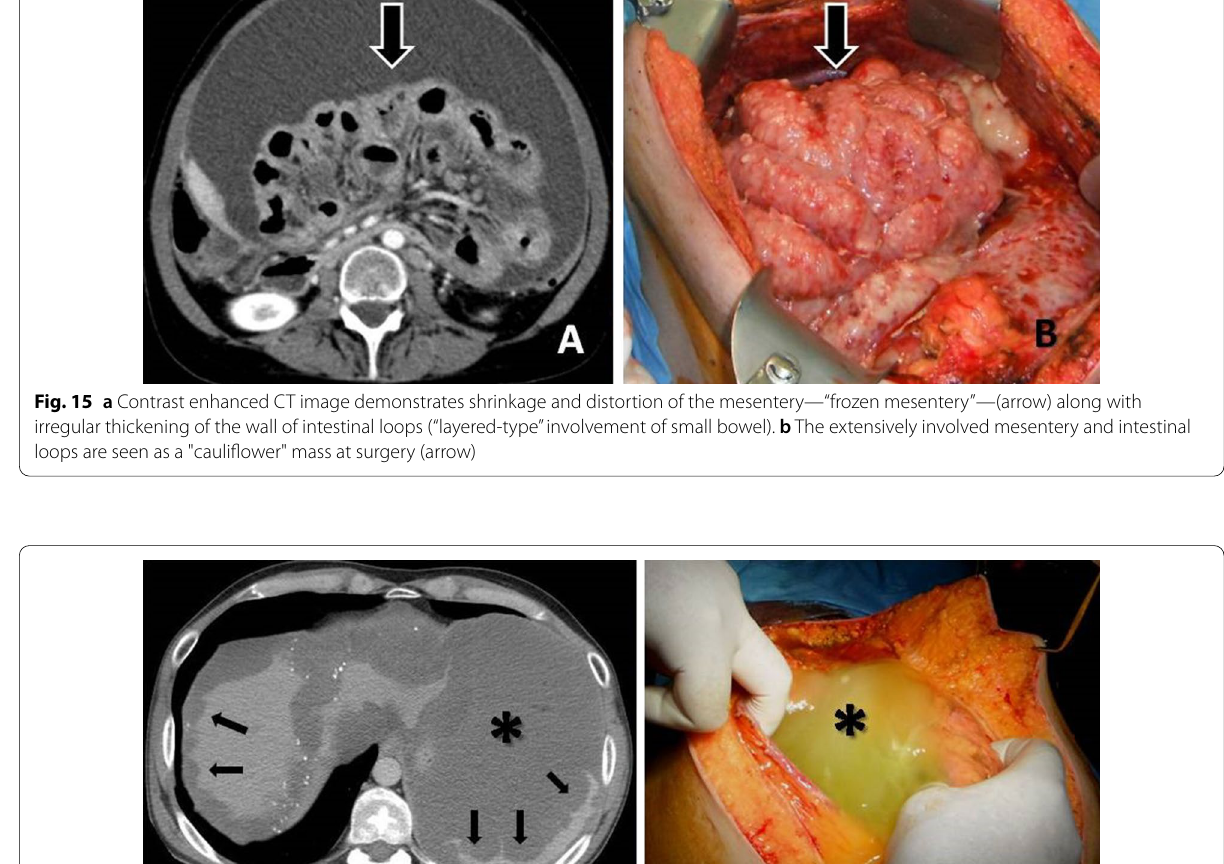
Malignant Pseudomyxoma peritonei